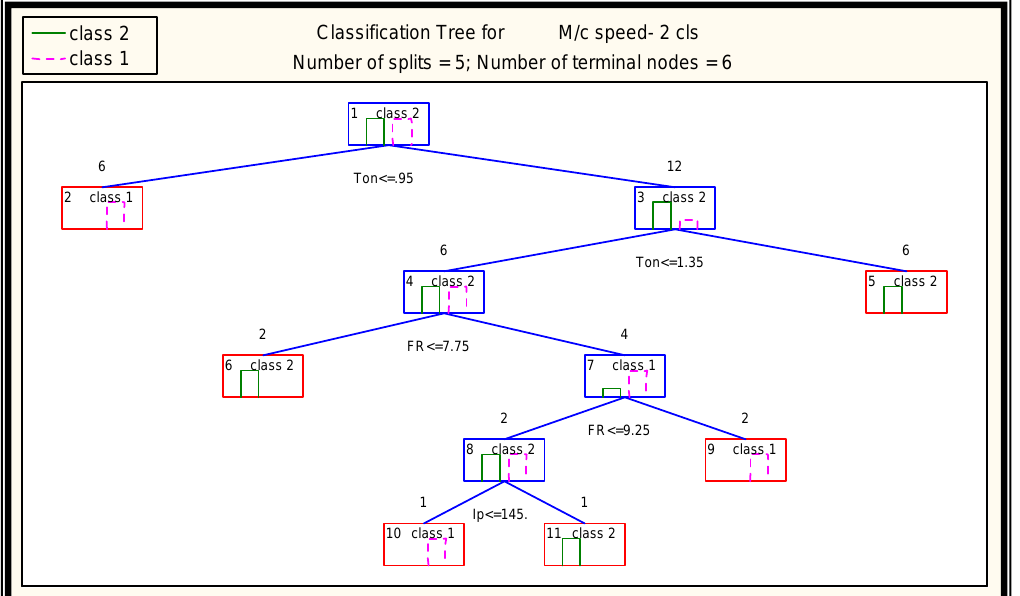
Fig. 7. Decision tree for machining speed (two classes)